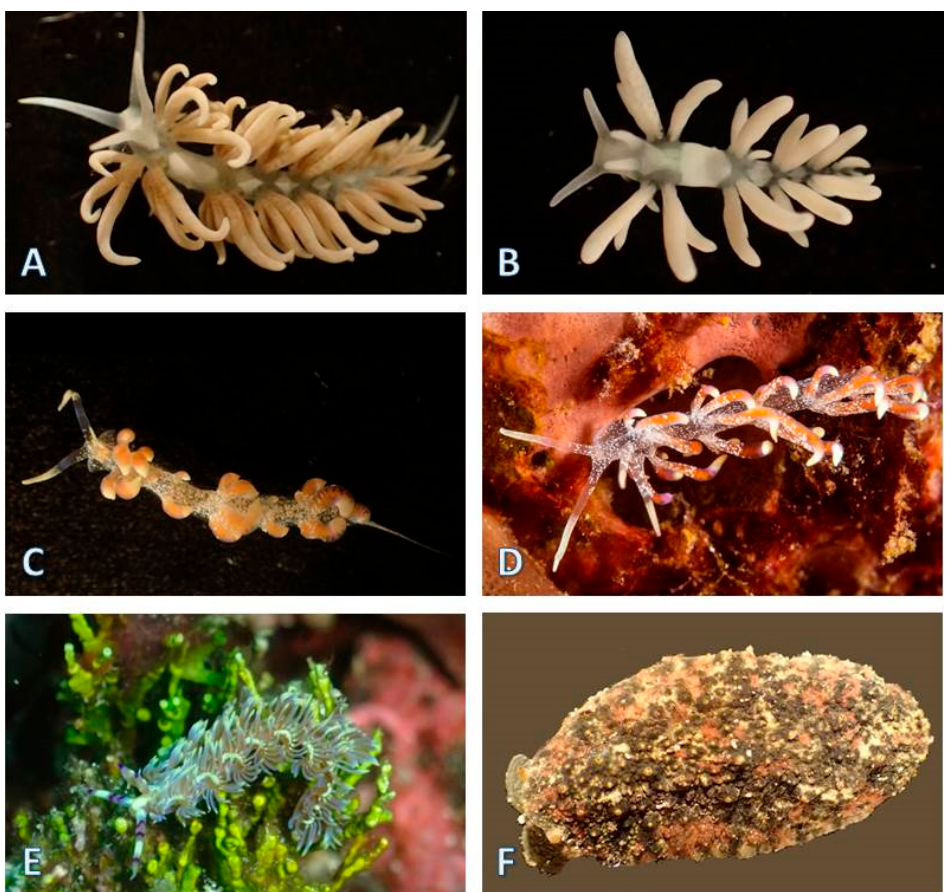
Figure 24. Nudibranchia Cladobranchia and Eupulmonata: ( A ) Phyllodesmium parangatum, Phpa18Ba-4; ( B ) Phyllodesmium pecten, Phpe18Ba-1 ; ( C , D *) Phyllodesmium poindimiei, Phpo18Ba-1 ; ( E ) Pteraeolidia semperi, Ptse17Ba-2; ( F ) Peronia sp. a, Onsp18Ba-1. Diversity 2020 , 12 , 52 35 of 72